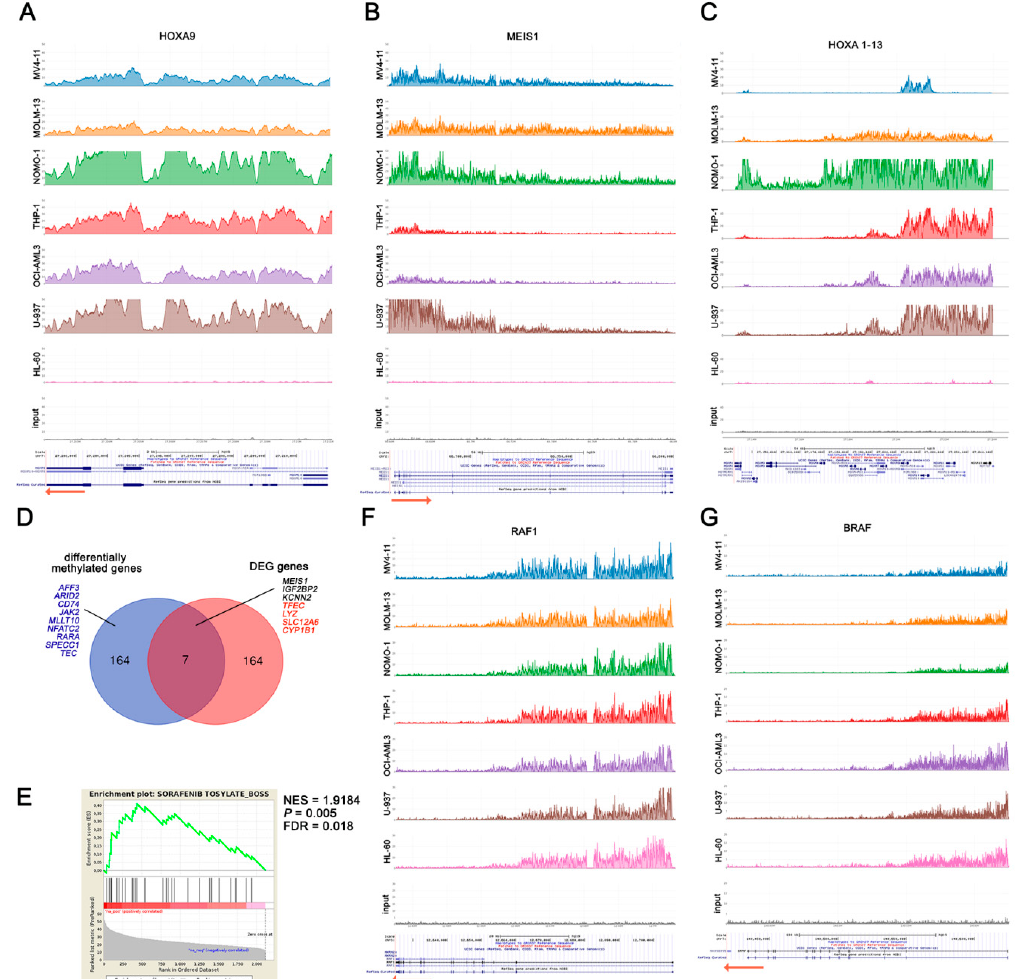
Figure 6. H3K79 methylation in MLL -r and non- MLL -r human AML cell lines. ( A – C ) are H3K79me2 profiles of MLL target genes. ( D ) Venn diagram showing the overlap between the 172 genes di ff erentially methylated in MLL -r compared to non- MLL -r human AML cell lines and the 171 genes di ff erentially expressed upon Pinometostat treatment and shared between at least three AML cell lines. Overlapping genes are reported (black: down-regulated genes; red: up-regulated genes). Additional genes with important roles in regulating signaling cascades, transcription, or cell development, and di ff erentially H3K79me2 enriched in MLL -r compared to non- MLL -r, are indicated in blue. DEG: di ff erentially expressed genes. ( E ) Gene set enrichment analysis (GSEA) of commonly H3K79me2 enriched genes in both MLL -r and non- MLL -r AML cells showing the enrichment in Sorafenib’s drug signature. The normalized enrichment score (NES) and the statistically significant False Discovery Rate (FDR) and p values are indicated. ( F ) and ( G ) are H3K79me2 profiles of RAF1 and BRAF , which encode for Sorafenib targets. Table 1. Selected DOT1L target genes with major roles in cell proliferation and survival.